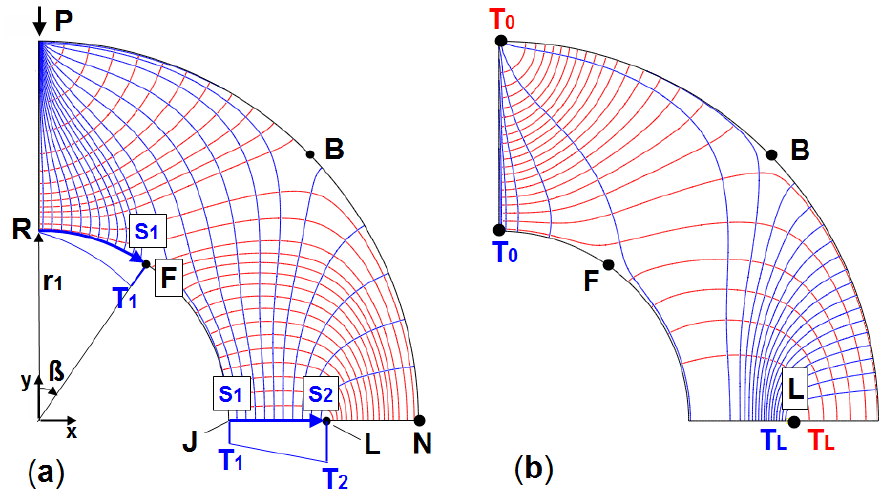
Figure 9. Circular ring analogous to Figure 8: ( a ) Determination of the σ 2 trajectory through specification of a linearly increasing temperature along RF and JL; ( b ) Simplified analysis with a two-node temperature boundary condition; T 0 and T L for the σ 1 trajectories, T 0 and T L for the σ 2 trajectories.